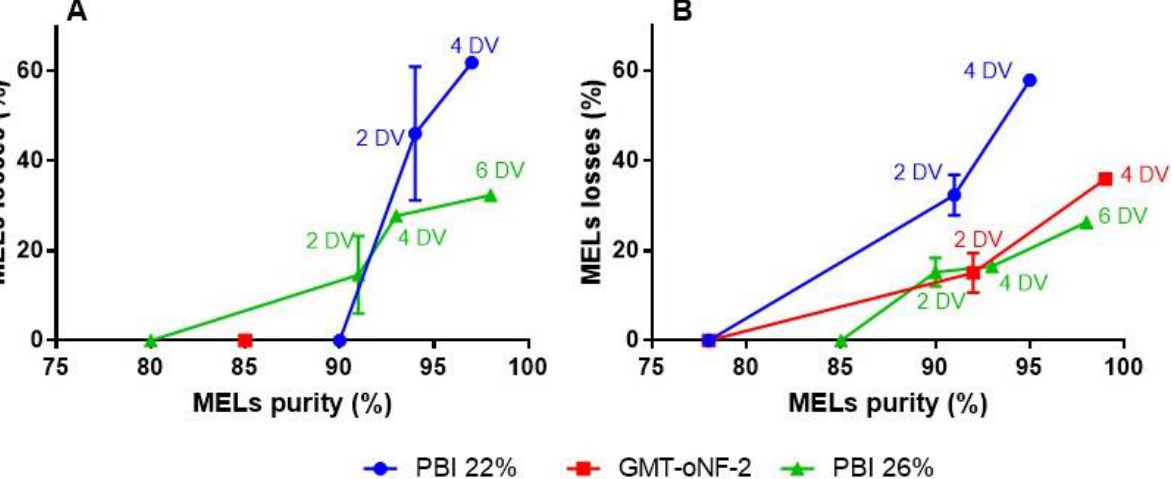
Figure 4. MELs purification through DV technology for different OSN membranes (PBI 22 (blue line with circles) and 26% (green line with triangles), and GMT-oNF-2 (red line with squares), using MeOH ( A ) or EtOAc ( B ) as organic solvents, for different DV (0, 2, 4, 6). All filtrations were performed by maintaining a volume of 50 mL and 15 bar of pressure.